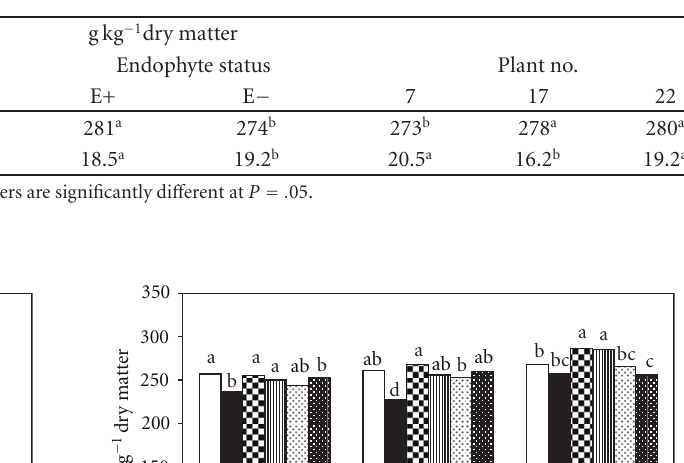
Table 3: Maturity, plant, and endophyte e ff ect on ADF and N concentration of tall fescue from the field study.